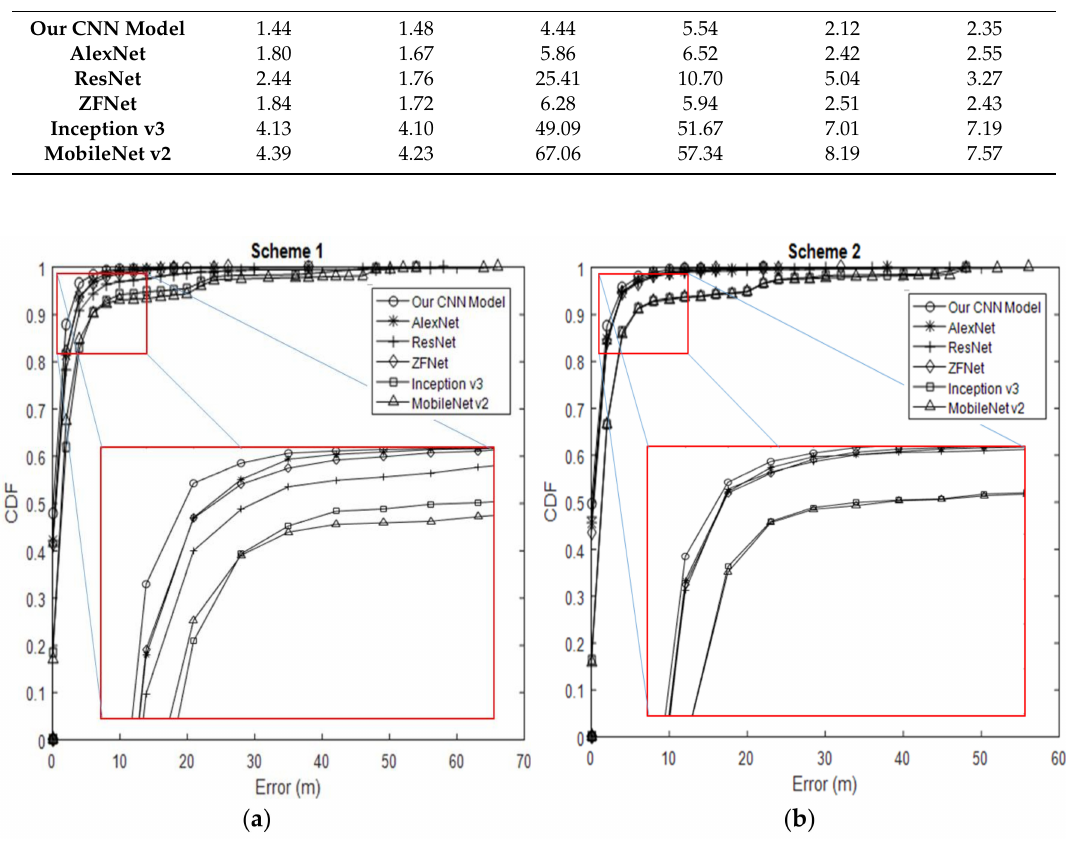
Figure 22. Cumulative distribution function (CDF) curves comparing position accuracy for CNN applications with our CNN model. ( a ) CDF for Scheme 1. ( b ) CDF for Scheme